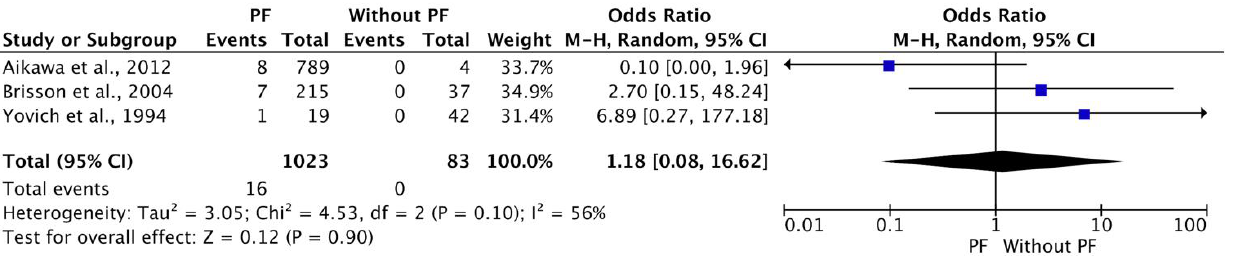
Figure 7. Meta-analysis for recurrence ratio on disc(s) adjacent to surgically treated area (with prophylactic fenestration; without prophylactic